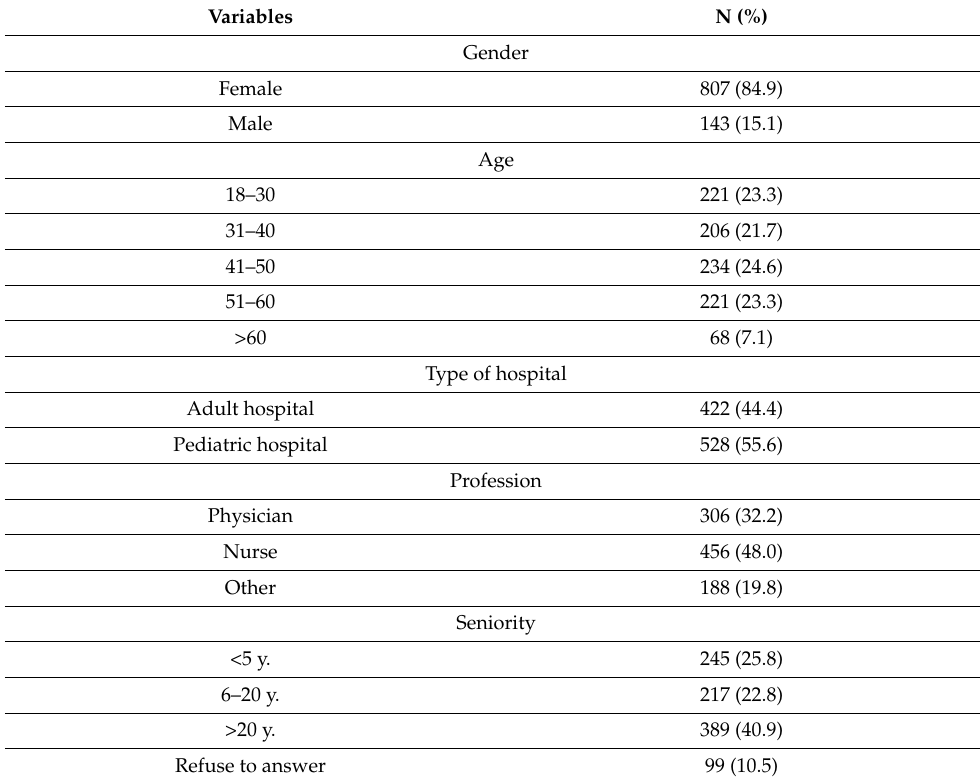
Table 1. Sociodemographic characteristics ( N = 950).